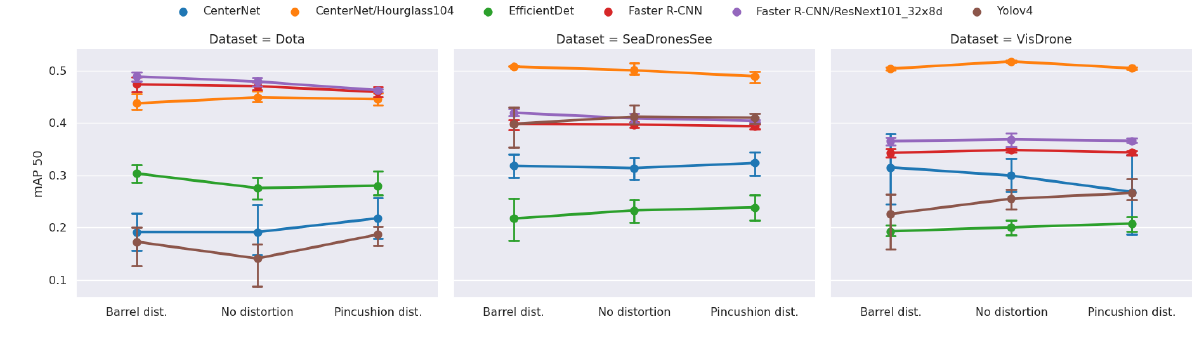
Figure A4. Image Distortion: the impact of the image distortion on the performance of the object detectors for all data sets. The y-axis shows the mean Average Precision (mAP).